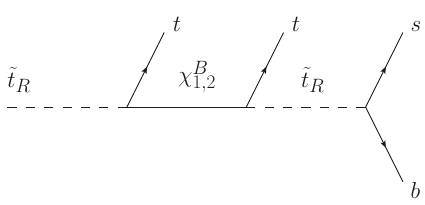
Figure 3. Decay of the stop through the two on-shell pseudo-Dirac states (cid:31) B mass di(cid:11)erence between the two states is smaller than the width, the diagram with (cid:31) B one with (cid:31) B 2